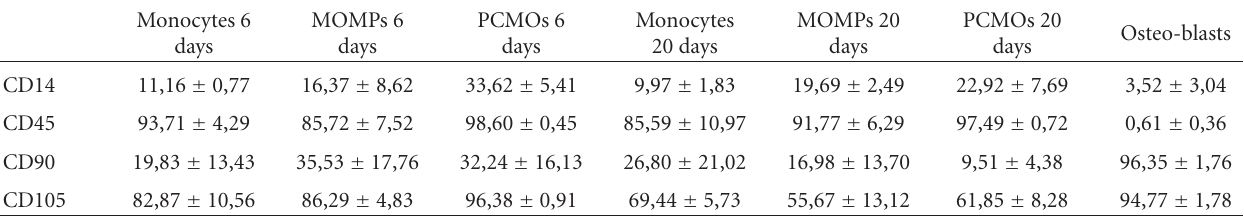
Table 2: Phenotype of monocyte-derived cells. Numbers indicating percentage of positive cells ± standard error of the mean (SEM) measured by FACS analysis from 3 independent